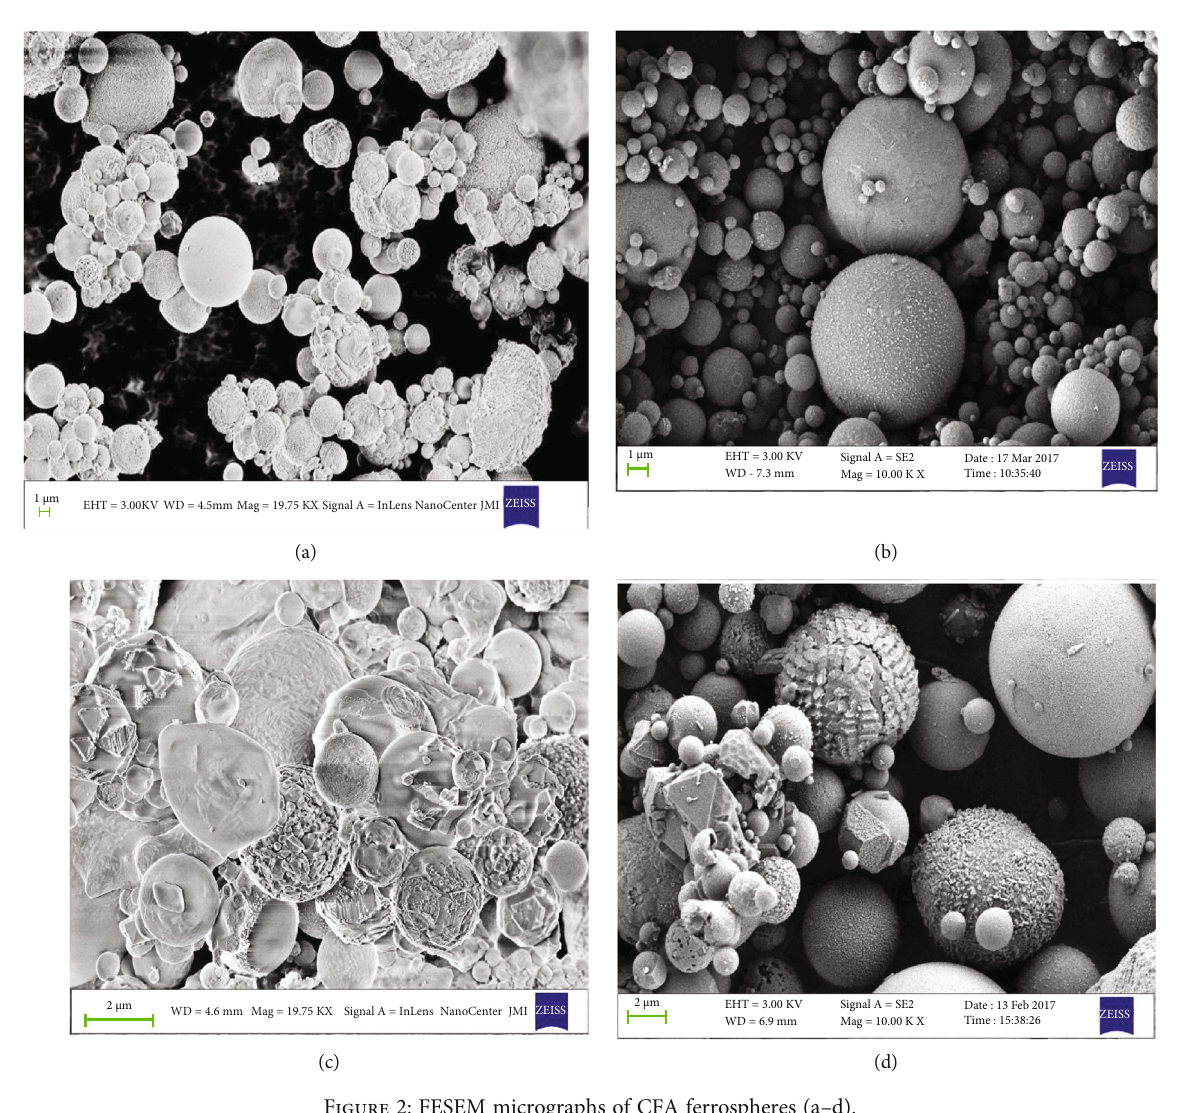
Figure 2: FESEM micrographs of CFA ferrospheres (a –